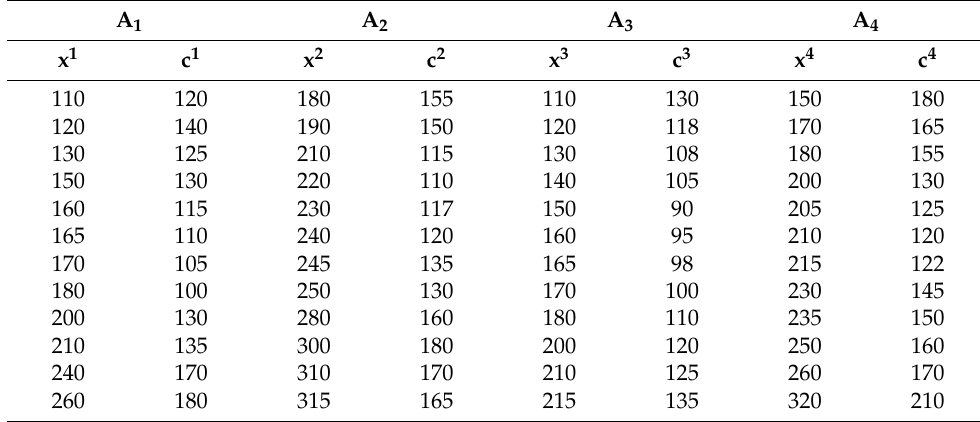
Table 5. Stock level and total cost of all products.